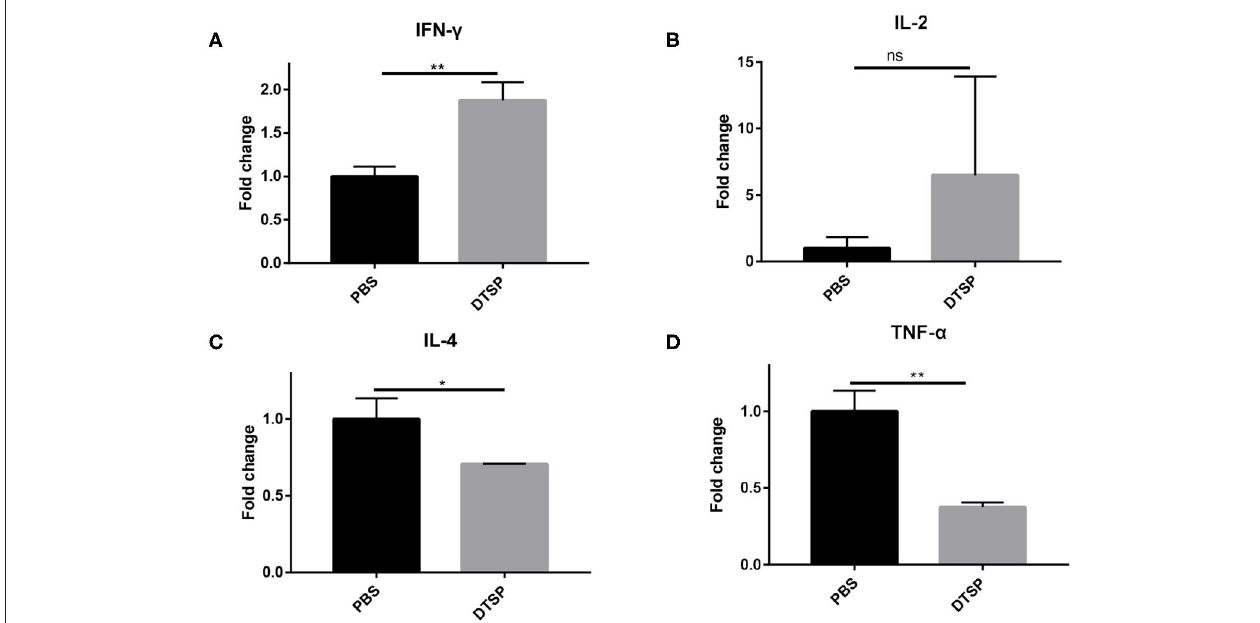
FIGURE 7 | Relative mRNA expression levels of cytokines in tumor tissues. Mice were sacrificed when tumor sizes reached nearly 1,000–1,500 mm 3 ; tumor tissues were collected and used for later mRNA expression determination. mRNA expression levels of (A) IFN- γ , (B) IL-2, (C) IL-4, and (D) tumor TNF- α were detected via real-time PCR. Relative mRNA expression in the DTSP-treated group was normalized to that in the PBS control group. Data are presented as means ± SD. * p < 0.05; ** p < 0.01; ns, not significant, Student’s t